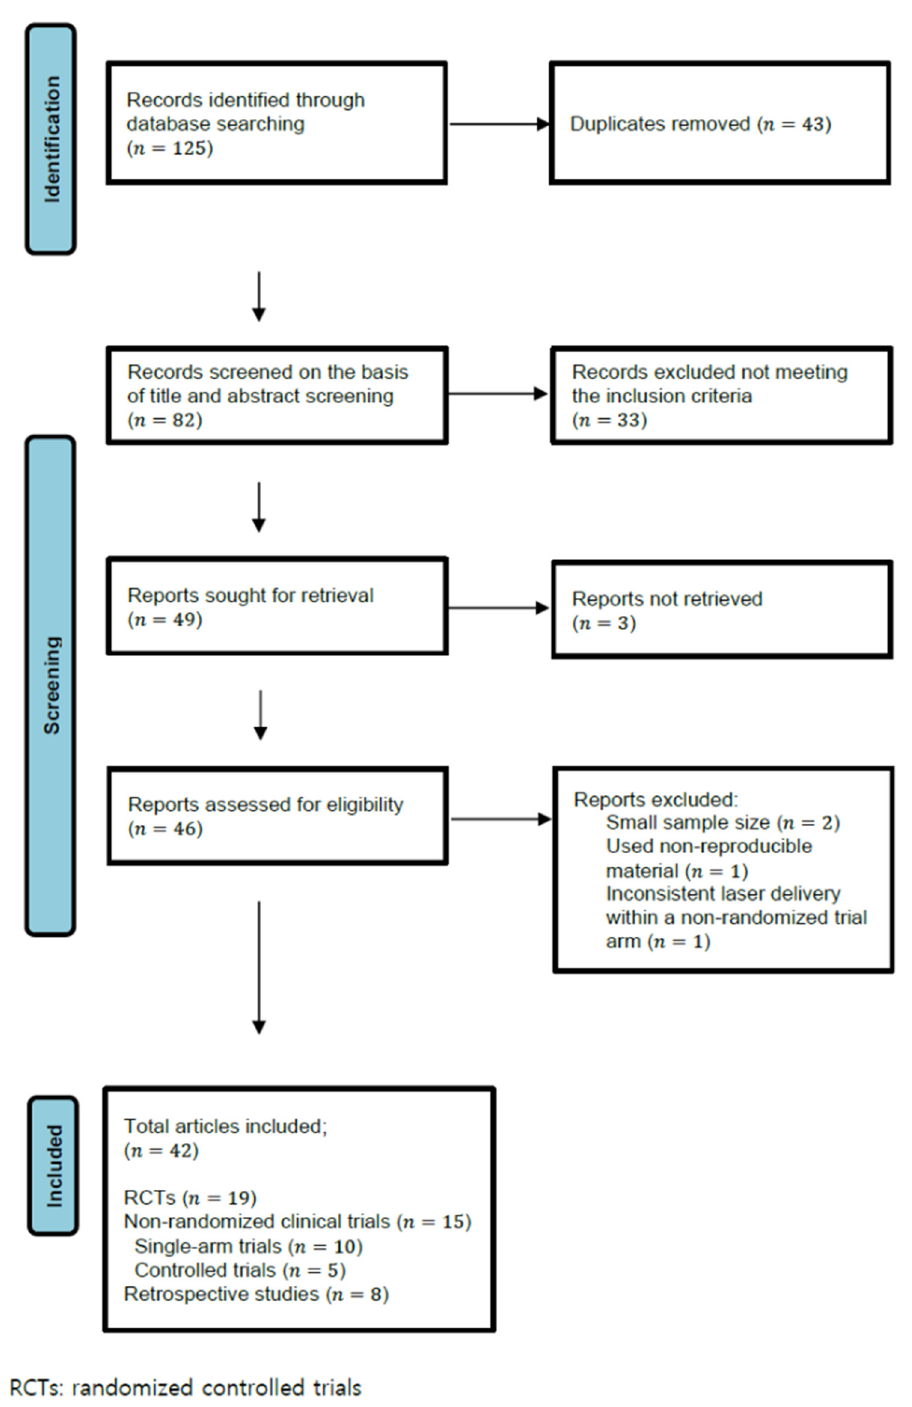
Figure 1. Literature search and article selection.